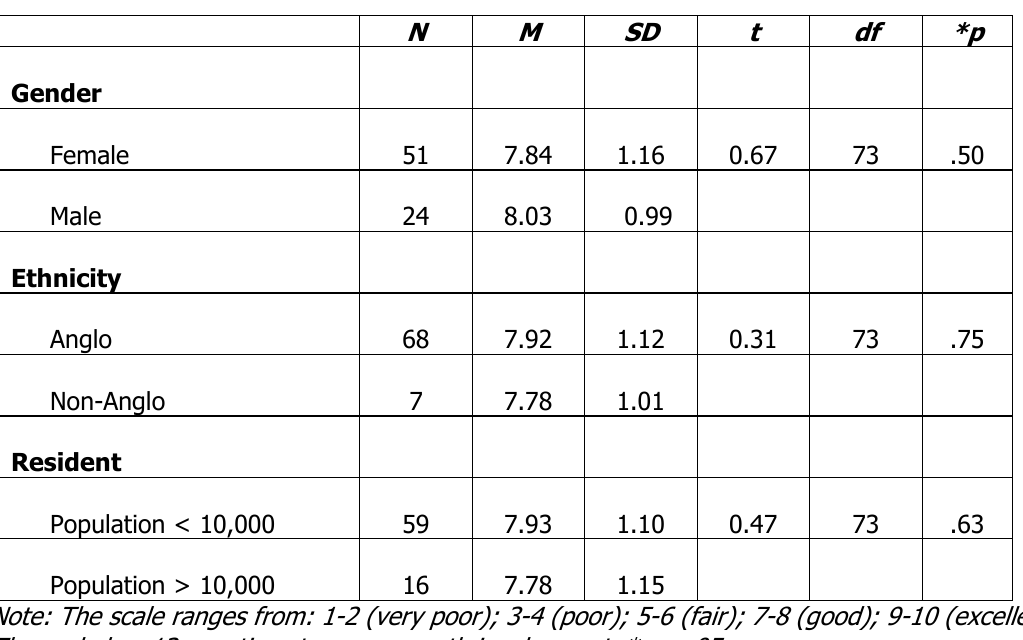
Youth Board youth member’s perception by gender, ethnicity and resident